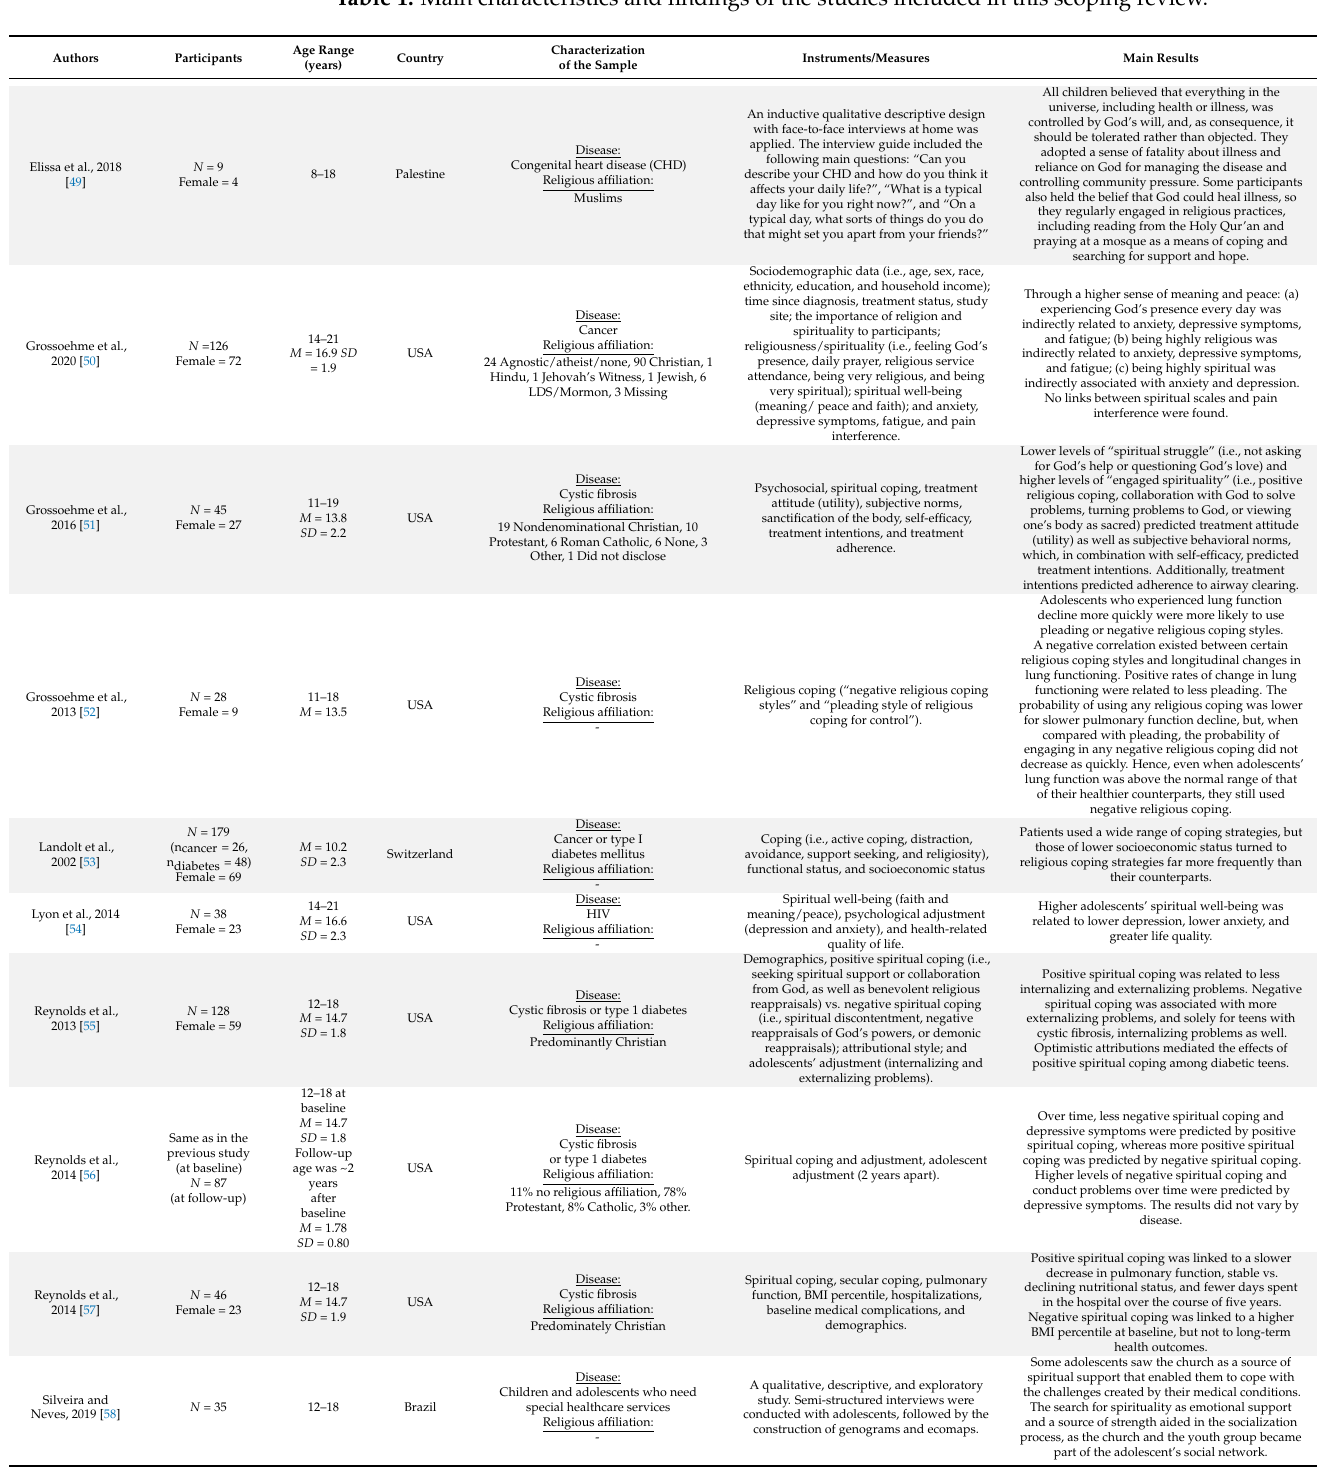
Table 1. Main characteristics and findings of the studies included in this scoping